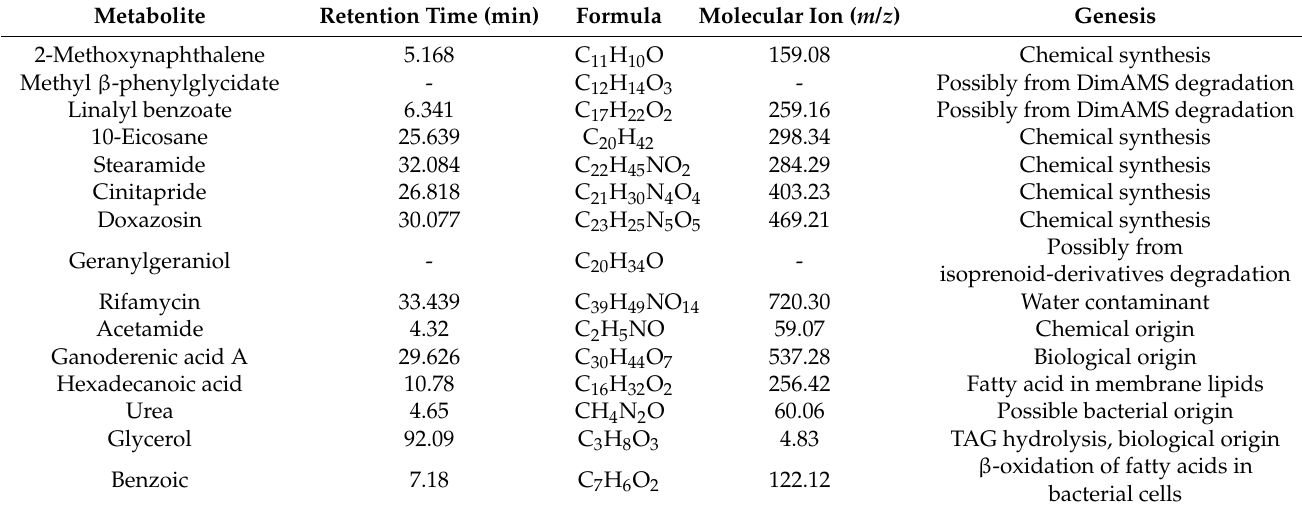
Table 5. Mass spectral data and possible origin of molecules present in the emulsions formed by bacterial cultures and phenolic industrial by-product stream (1420 ppm PS) after 7 days of incubation.